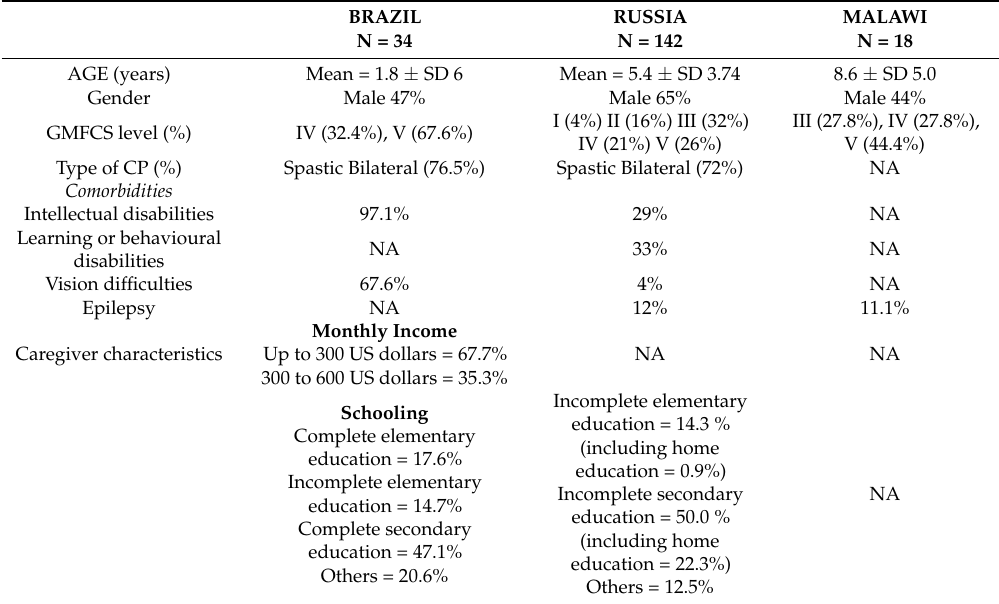
Table 1. Participants; characteristics by